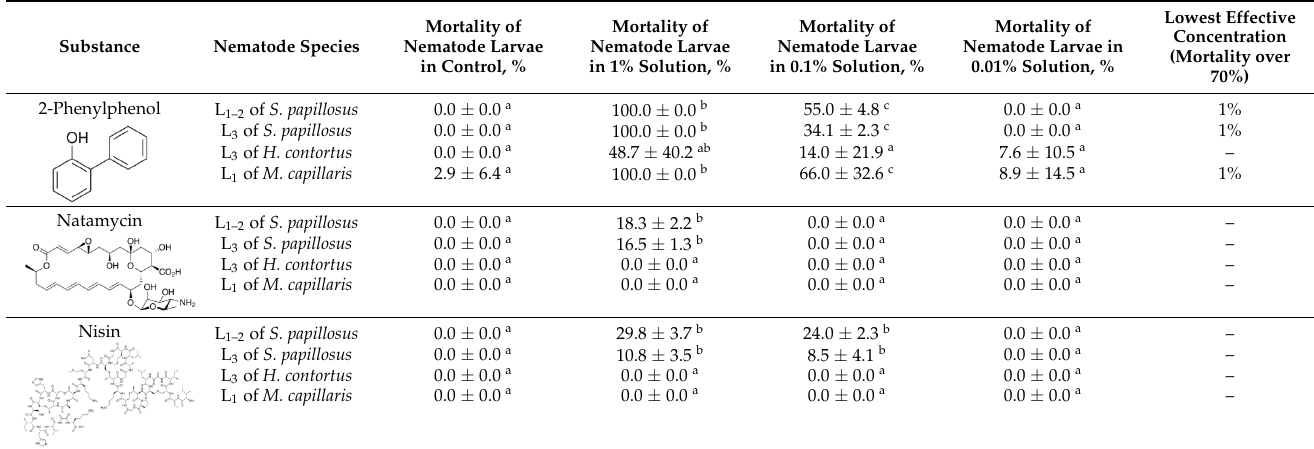
Different letters in Table 5 within each line indicate significant ( p < 0.05) differences between groups according to Tukey ’ s test